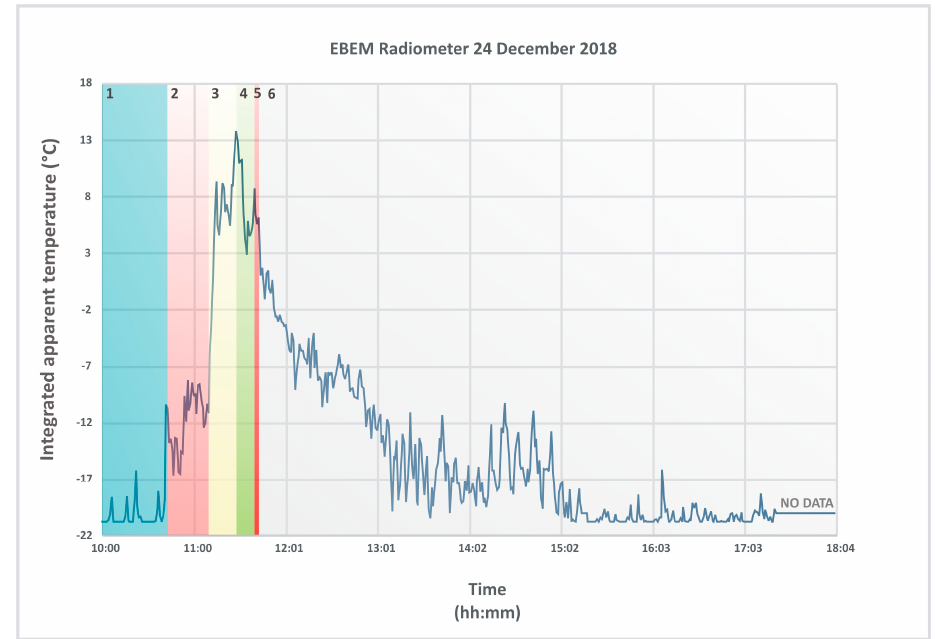
Figure 7. Integrated apparent temperatures recorded by the EBEM radiometer on 24 December 2018. Data reported are the root-mean-square (RMS) of the 50 Hz signal calculated over a time window of one min. The colored areas in the graph indicate different phases of the eruptive activity and eruptive fissure opening and developing.